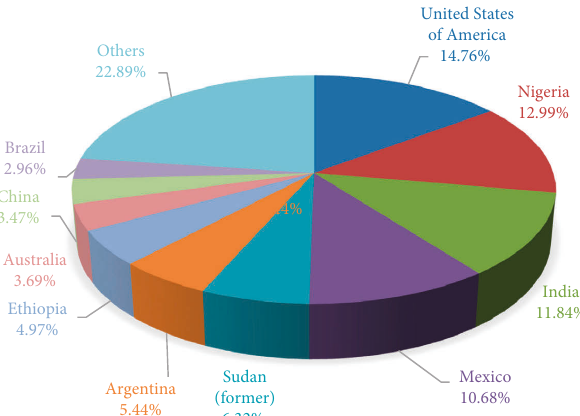
Figure 2: Area (ha) and production (MT) trend of sorghum in Ethiopia. Source: FAOSTAT, a report from 2006 to